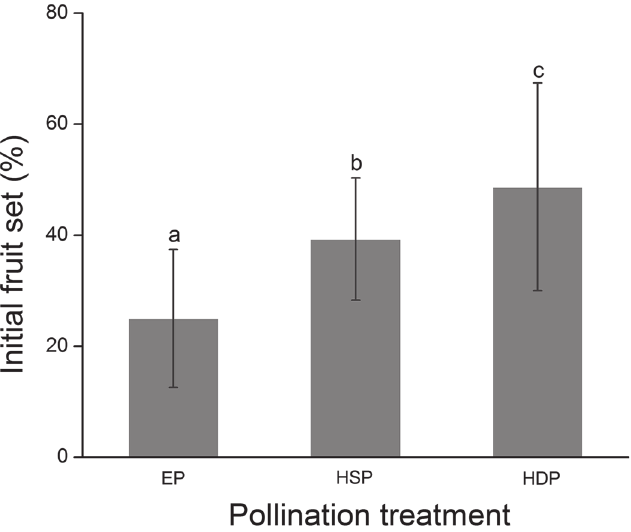
Fig 2. Initial fruit set of peach under greenhouse conditions. The initial fruit set (Mean ± SD) from flowers under different pollination treatments. Different letters indicate significant differences ( P < 0.05) among pollination treatments using the Fisher test. EP: Pollinator exclusion; HSP: Hand-pollination with pollen from the same flower; HDP: Hand-pollination with pollen from a different flower.